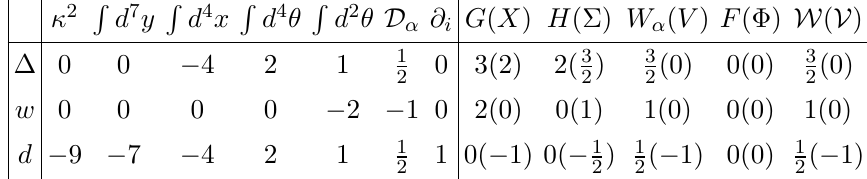
Table 3 . Superconformal weights ((cid:1) and w ) and engineering dimension ( d ) of various